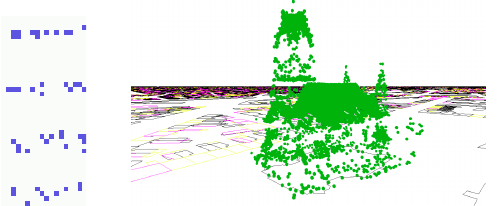
Figure 1: Left picture shows resolution of LiDAR point cloud: Each pixel is of size 10 cm 10 cm, the points are organized in × stripes. The right picture displays all points of Luther church.